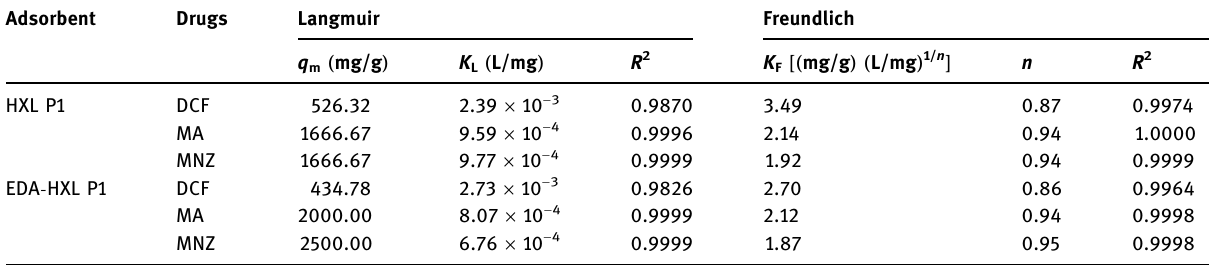
Table 5: Isotherm parameters of drugs adsorption by HXL P1 and EDA - HXL P1 terpolymers Adsorbent